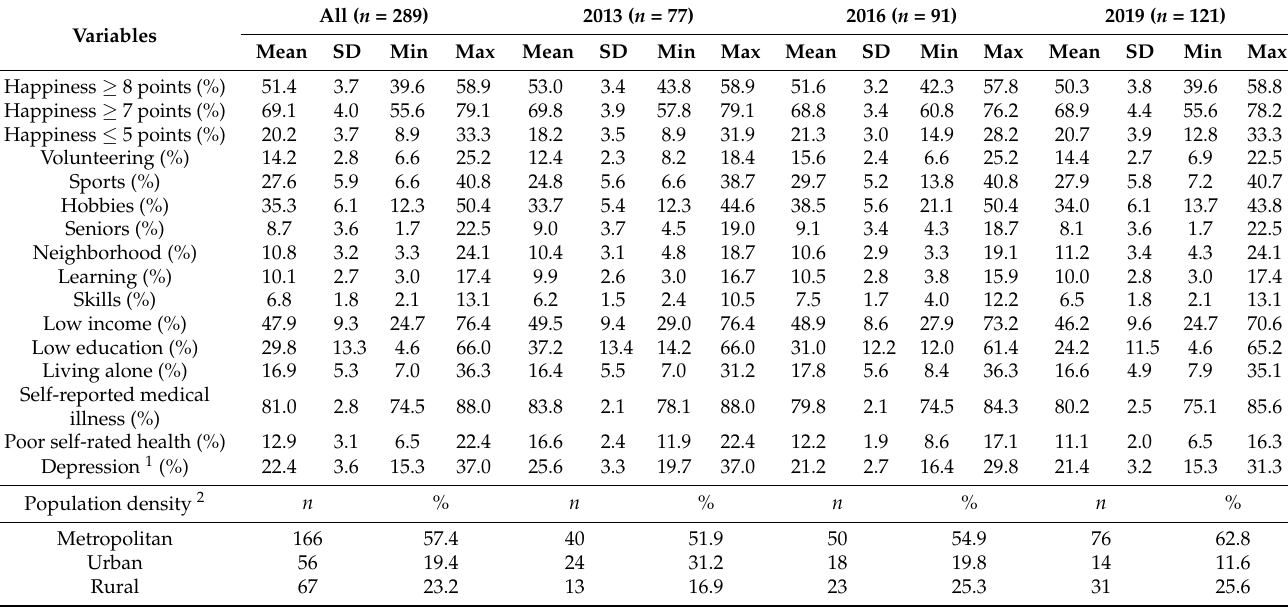
Table 1. Age-adjusted descriptive statistics of municipal